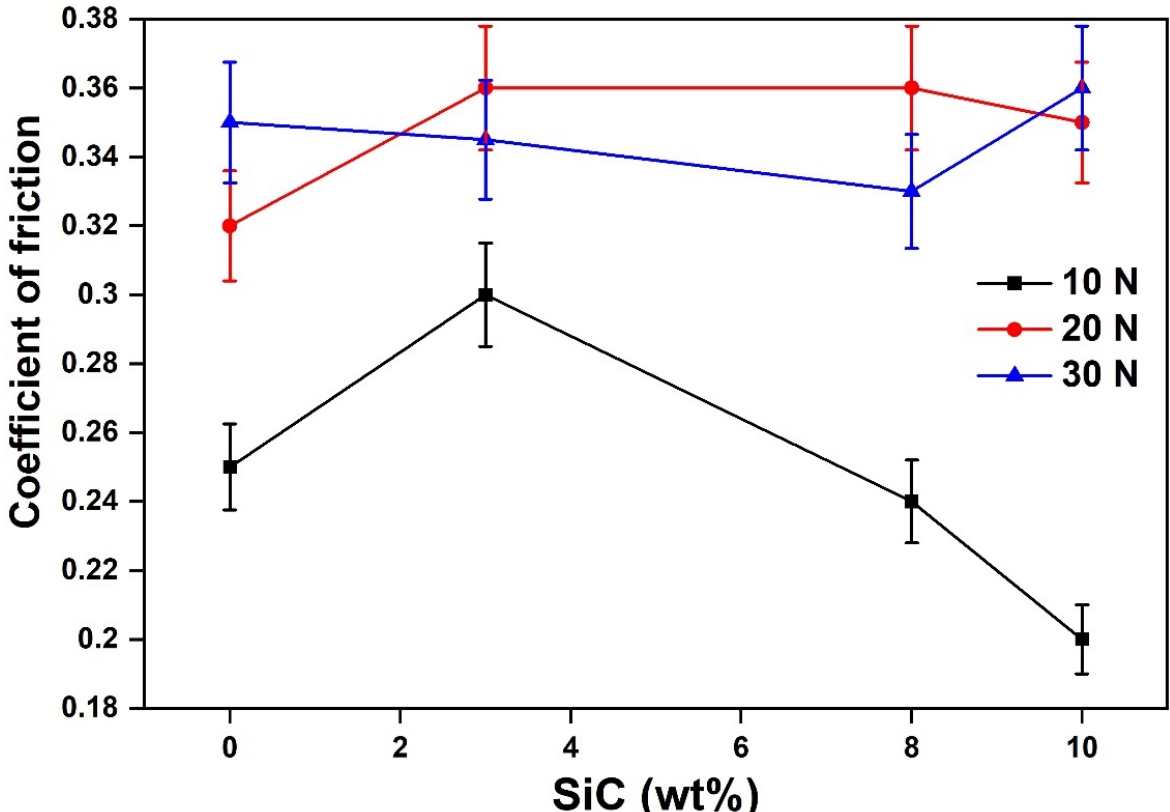
Figure 7. Variation of coefficient of friction of Al-MMCs with SiC content at different load and constant velocity of 1 m/s.